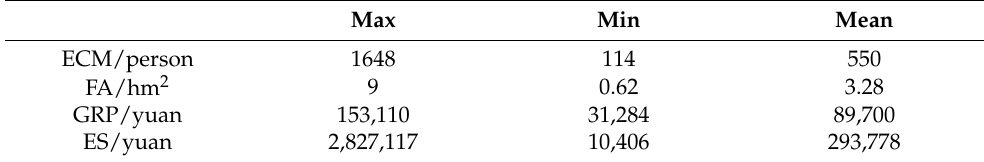
Table 1. Socioeconomic conditions and building